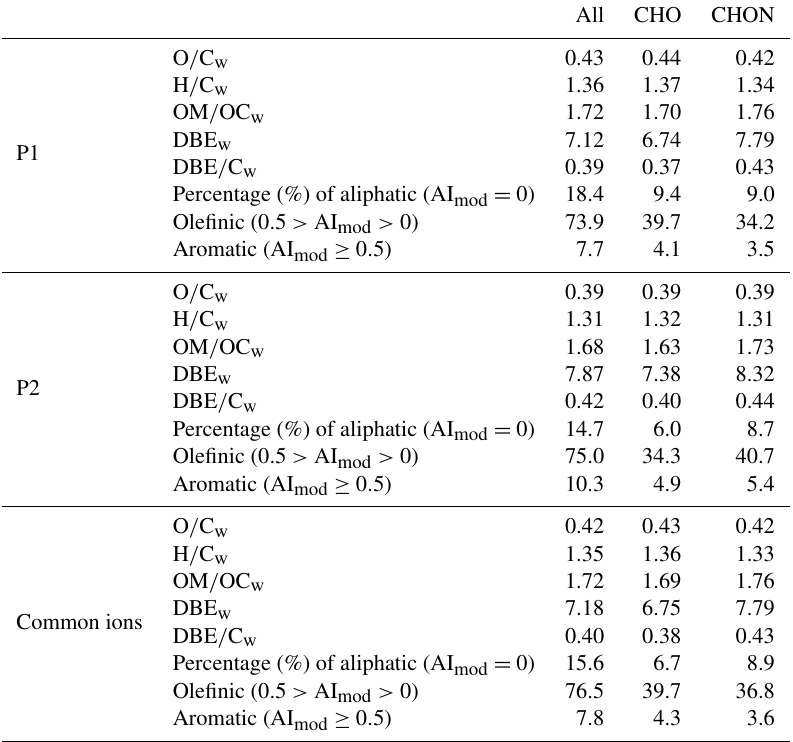
Table 1. Chemical characterization of all molecular assignments detected in WSOM for P1, P2, and common ions. Relative intensity weighted (“w”) for each data subset (O / C, H / C, OM / OC, DBE, and DBE / C) is given.